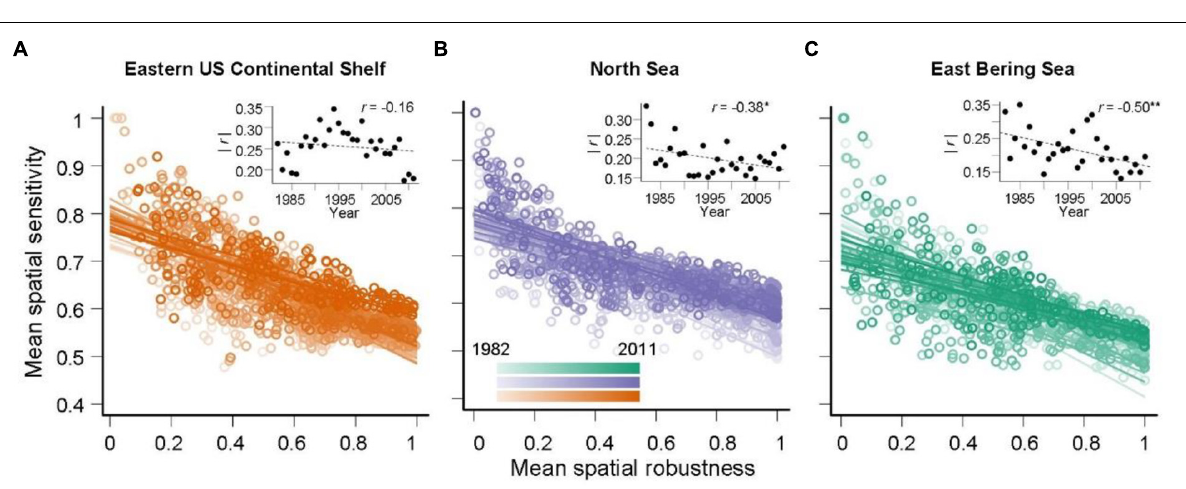
Frontiers in Marine Science |